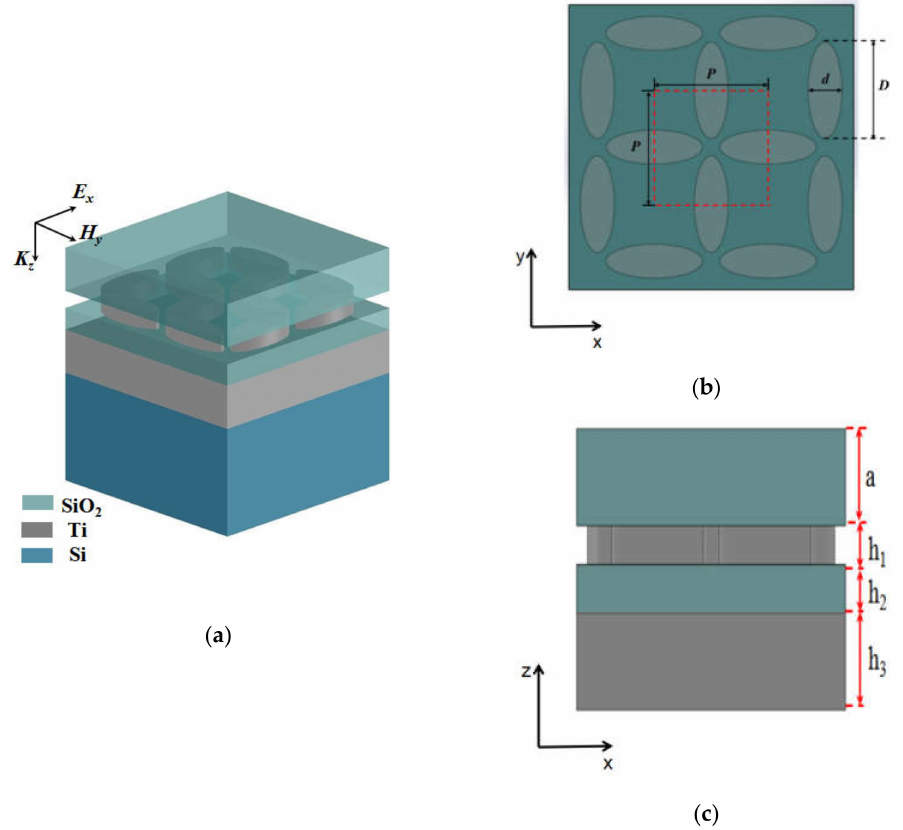
Figure 1. Ultra-broadband perfect absorber. ( a ) Three-dimensional view of the ultra-broadband perfect absorber. ( b ) Top view; the dotted red line represents a full unit cycle in simulation. ( c ) Side